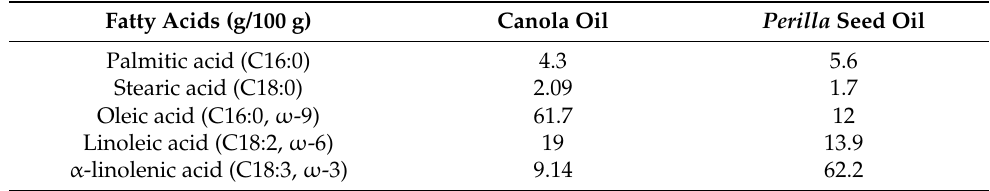
Table 1. Basic fatty acid component of canola oil and perilla seed oil. Fatty Acids (g/100 g) Canola Oil Perilla Seed Oil Palmitic acid